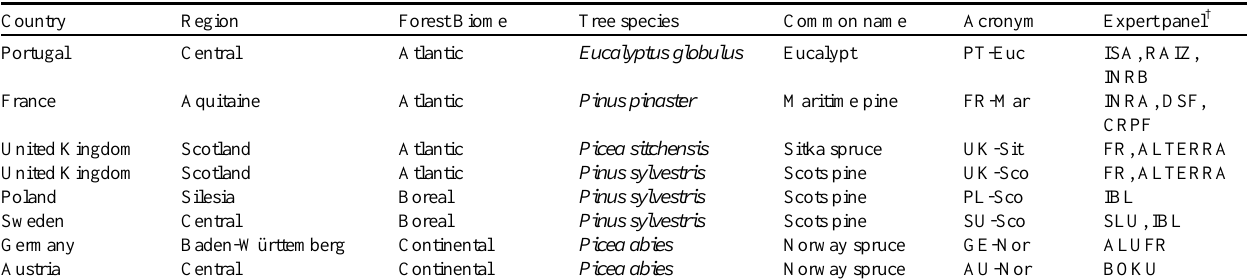
Table 2. List of regional case studies used in the MCRA